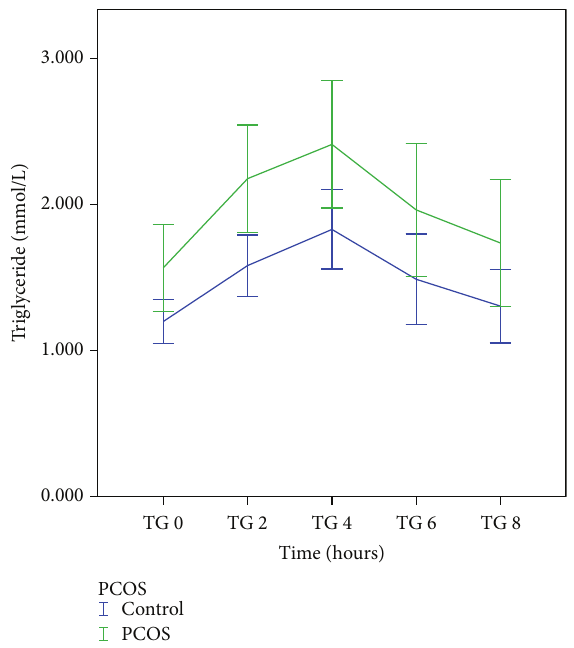
Figure 1: Postprandial triglyceride response in PCOS and control subjects.